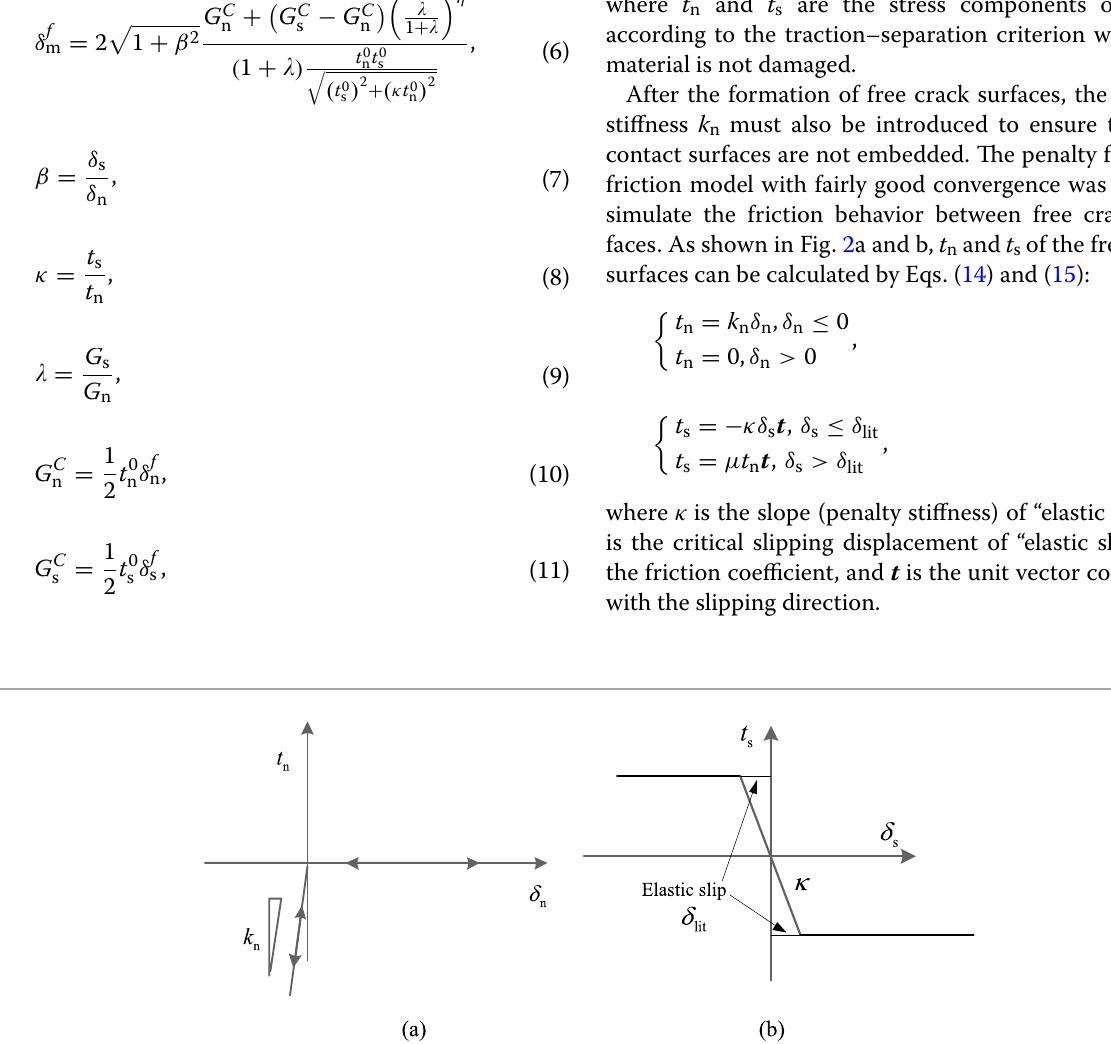
Fig. 2 Relationship between ( a ) t n and δ n , and ( b ) t s and δ